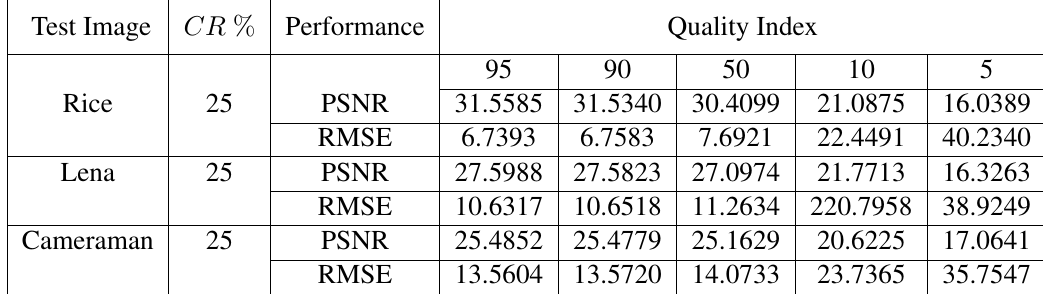
Table 1: Compression performance at different reconstruction qualities in the case of 2 × 2 blocks.